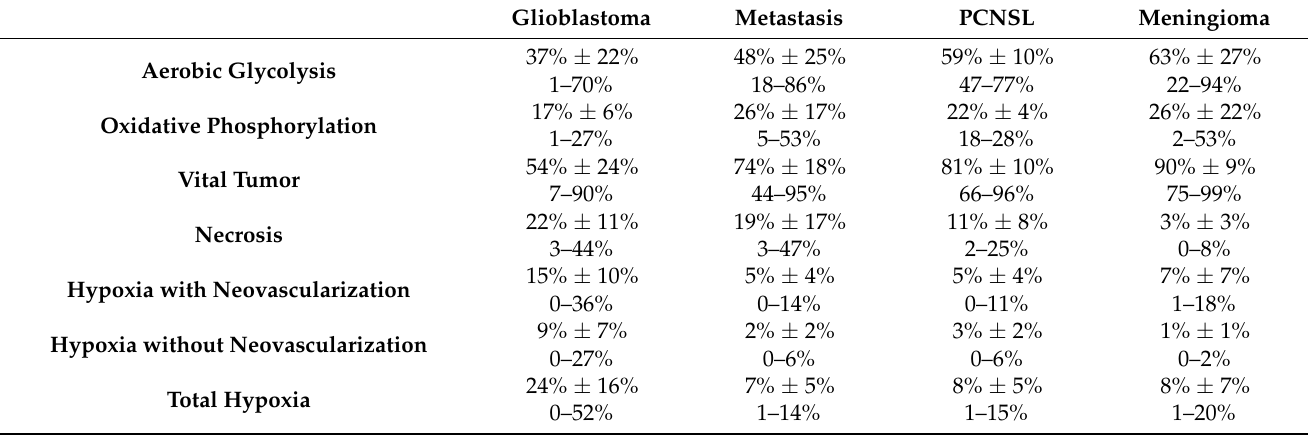
Table 1. Distribution of the TME compartments for the four contrast-enhancing brain tumor entities. Glioblastoma Metastasis PCNSL